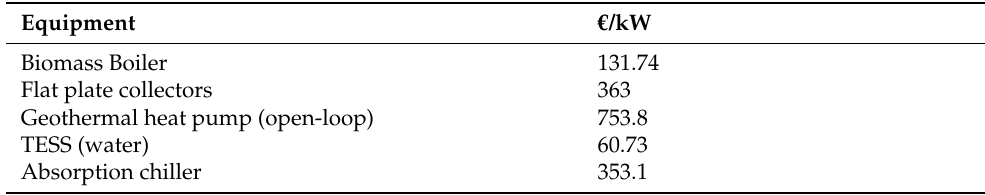
Table 8. Levelised costs of produced energy per technology used [46,47].